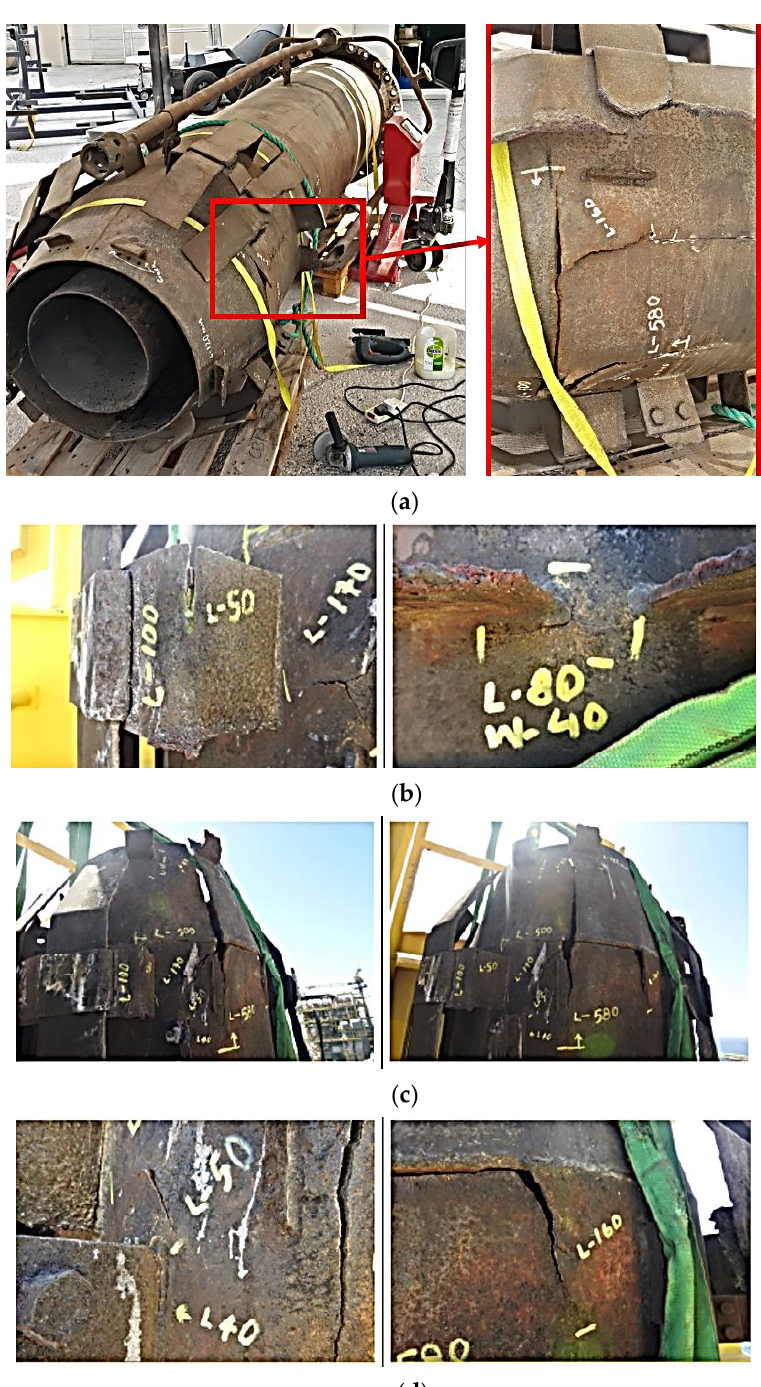
Figure 3. Failure regions of the different components of the flare in the vicinity of the welding region. ( a ) The cracks location. ( b ) Crack at wind deflector and crack on upper flare body near degraded wind deflector. ( c ) Crack at conical flare body. ( d ) Zoomed crack at conical flare body.